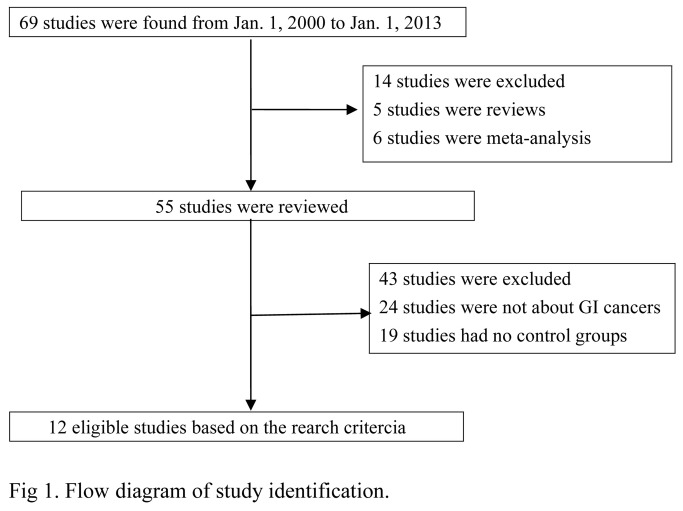
Flow diagram of study identification.